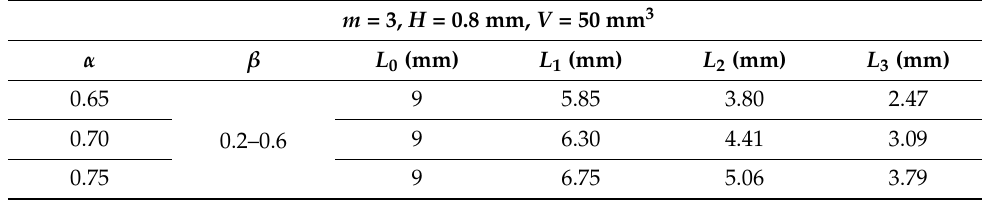
Table 1. Geometric parameters of branched HCM with different α .